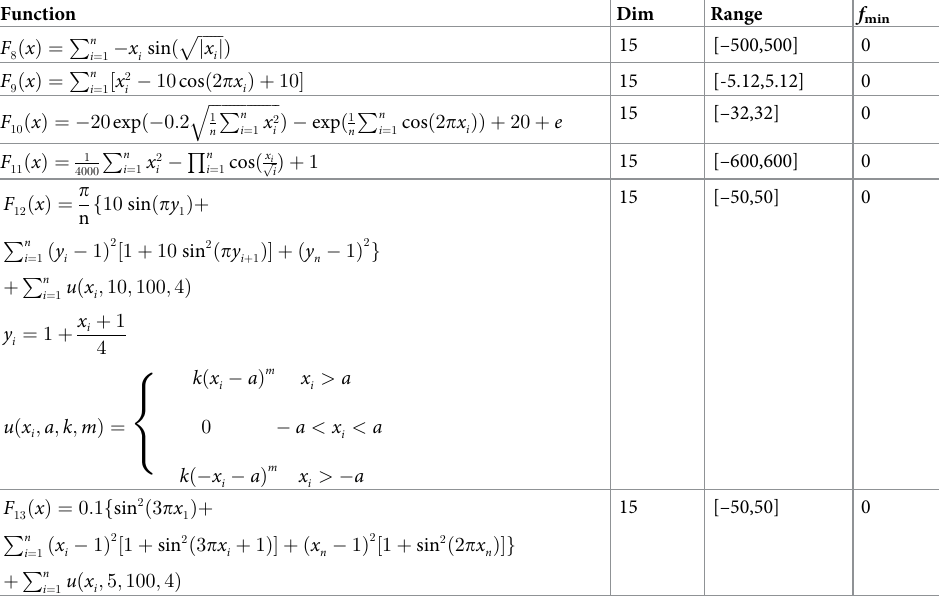
Table 2. Multi-modal benchmark